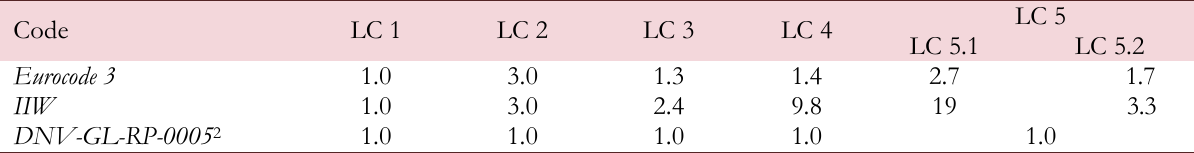
Table 3a: Normalized effect of stress multiaxiallity on fatigue damage predicted using selected codes – Comparison between the different codes.